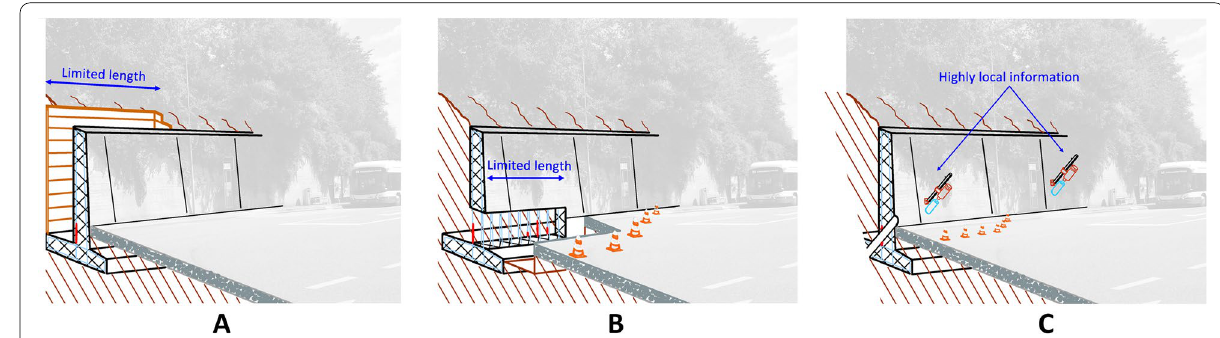
Fig. 1 Current inspection methods for RC retaining walls. The corrosion damage is marked in red at the backside of the wall: A Excavation of backfill, followed by concrete cover removal and visual inspection of the corrosion state from the backside; B Removal of concrete with hydro-jetting and visual inspection of the corrosion damage from the front side; C Extraction of drilling cores from the front side for analysis in the laboratory